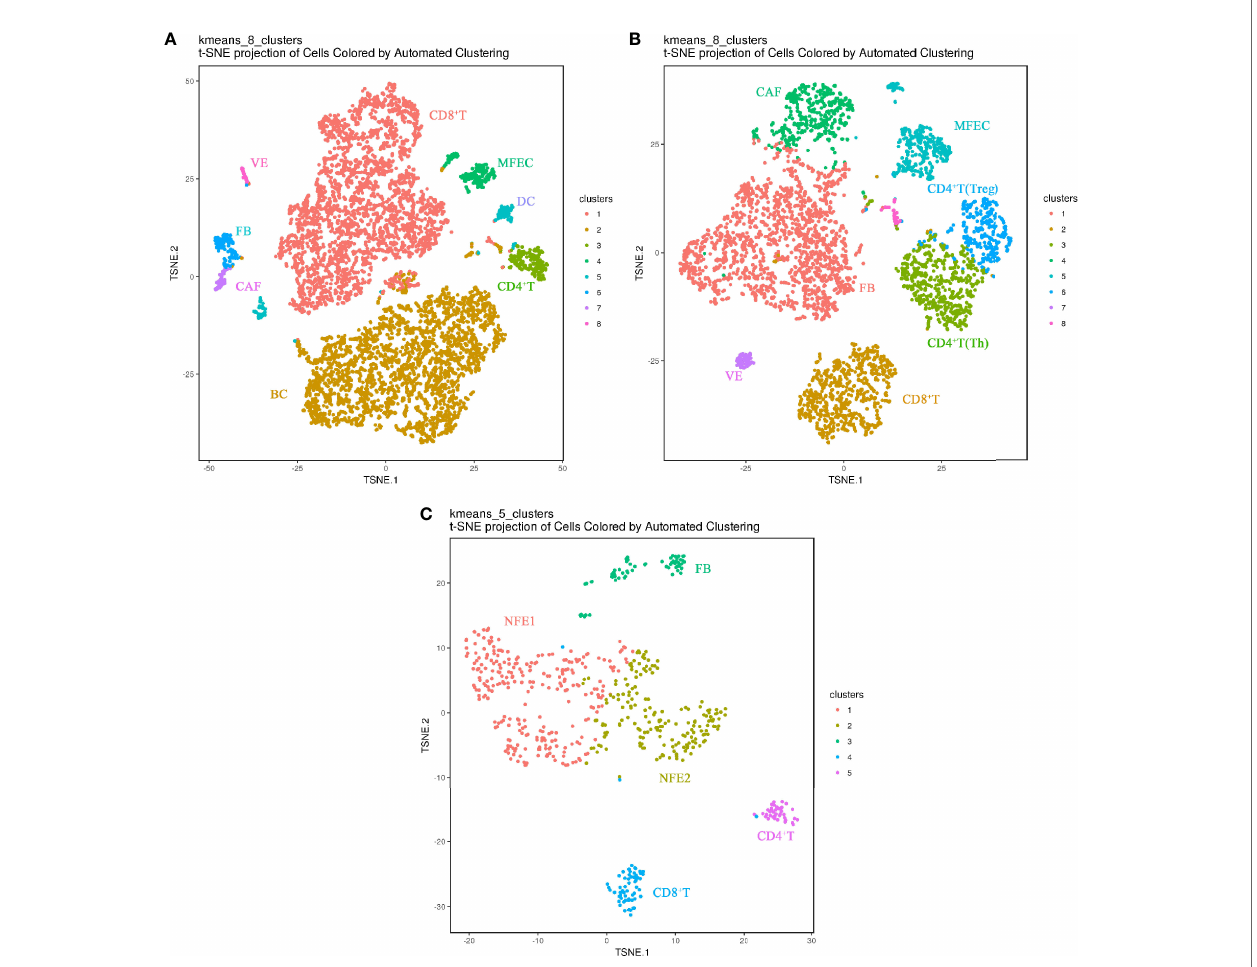
FIGURE 2 | Cell landscapes of matched PTC samples by single-cell transcriptomic analysis(The closer together cells are plotted, the more similar they are; k-means cluster assignment is indicated by color; clusters are labeled based on expression of canonical marker genes). (A) t-SNE plot demonstrating eight main cell types in primary PTC(Ca). (B) t-SNE plot demonstrating eight main cell types in metastatic PTC(LN). (C) t-SNE plot demonstrating fi ve main cell types in paracancerous normal tissue(PCa). NFE, Normal Follicular Epithelial cell; ME, Malignant Epithelial cell; VE, Vascular Endothelium cell; FB, Fibroblast cell; CAF, Cancer-associated fi broblast; DC, Dendritic cell; Treg, Regulatory T cell; Th, helper T cell; BC, B